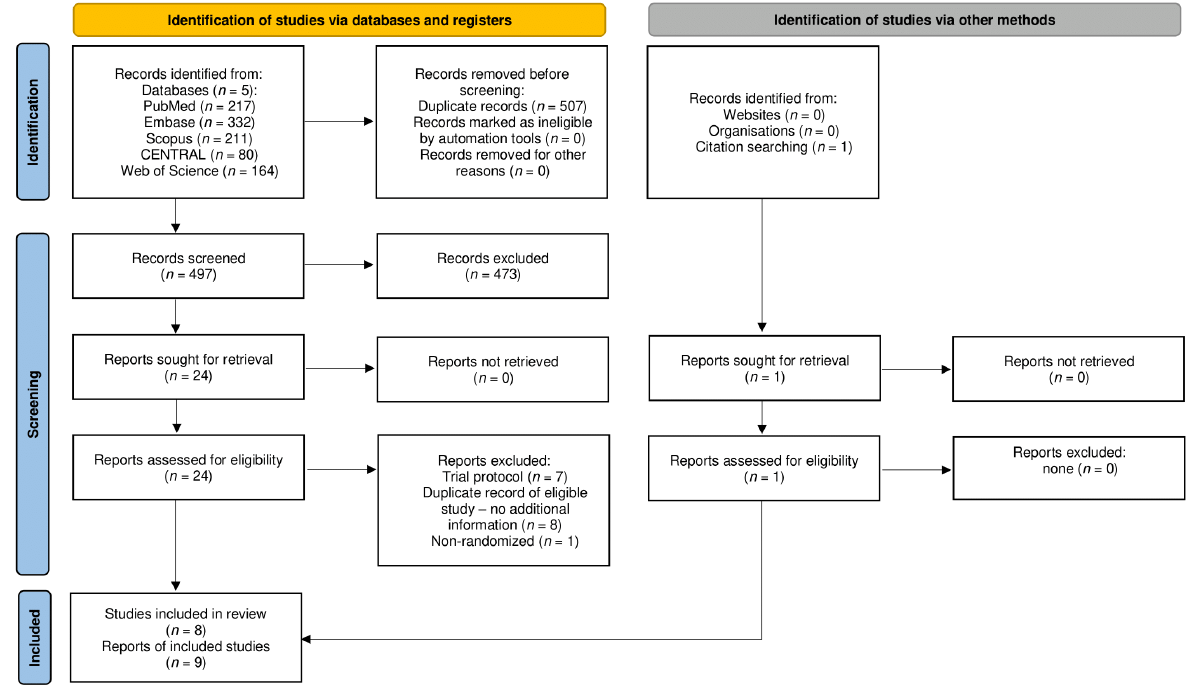
Figure 1. Flow diagram of study selection process. Table 1. Main characteristics of the included studies *: the abstracts published by Vasudevan and Reddy et al. refer to the same RCT, hence the total number of patients analyzed is 557. Abbrevia-